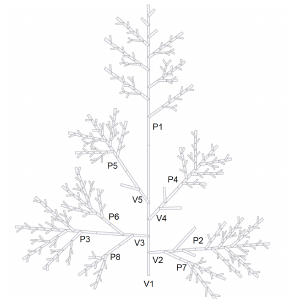
Figure 11. The rice panicle is composed of a main axis and lateral systems V i , each made of one or several inflorescences P j .